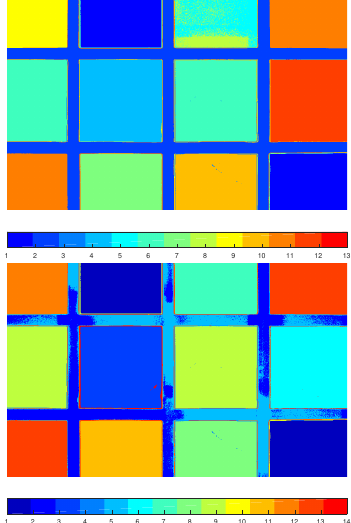
Figure 7. K-spatialmedian clustering results when K is 13 and 14 for incomplete FPI data Figure 9. K-spatialmedian clustering results when K = 13 for simulated pushbroom data, where every second band is read from second line (E2 data set), every fourth band from fourth line (E4 data set) and every tenth band from tenth line (E10 data